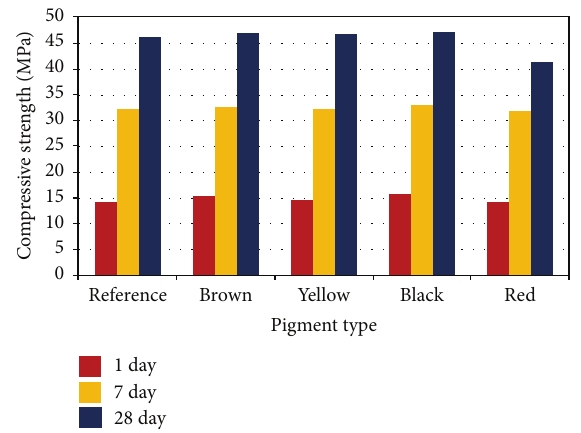
Figure 1: Compressive strength tests for mortars obtained using different pigments.